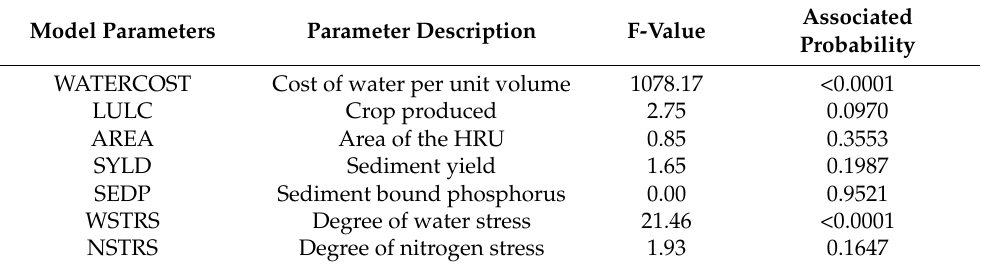
Table 2. Results of analysis of variance (ANOVA) in determining the factors that influence the model irrigation system